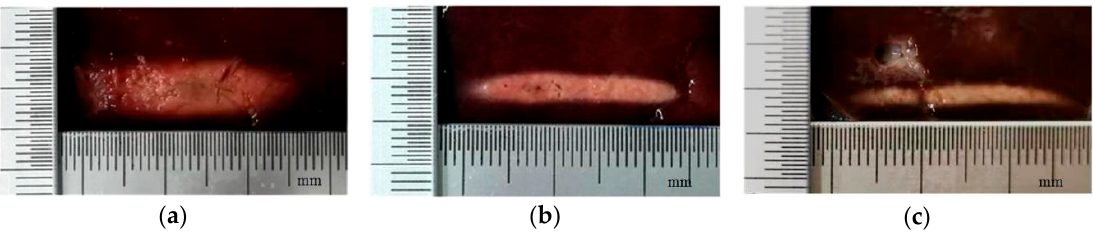
Figure 10. BFRs of bovine liver after ultrasonication with different combinations of acoustic power and time: ( a ) 50 W × 170 s, ( b ) 100 W × 27 s, ( c ) 125 W × 10 s.